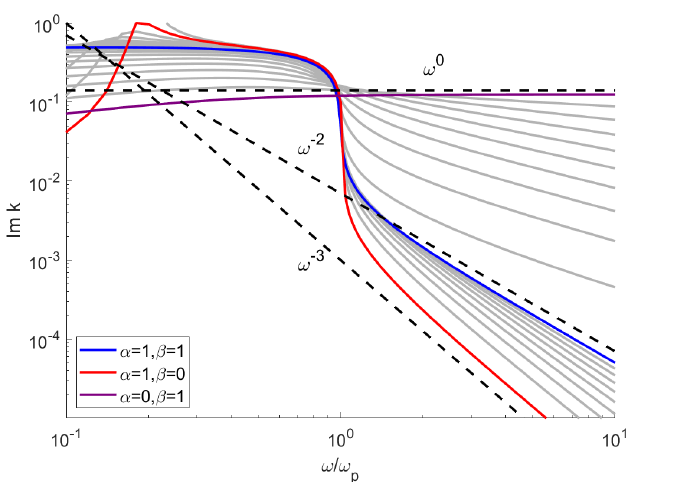
Figure 3. Imaginary value of the wave vector as a function of frequency, calculated for various values of α and β